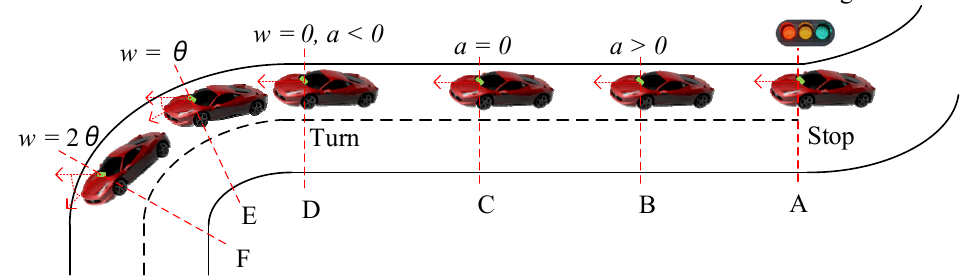
Figure 5. Schematic diagram of vehicle driving state determination.